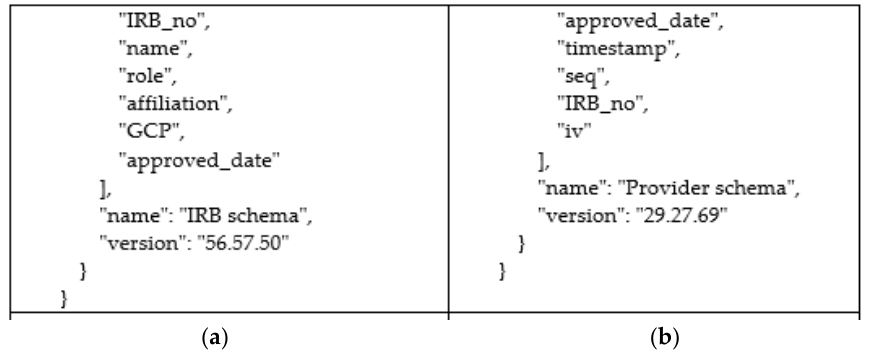
Figure 6. The schema definition written in JSON. ( a ) IRB schema; ( b ) CDM provider schema.